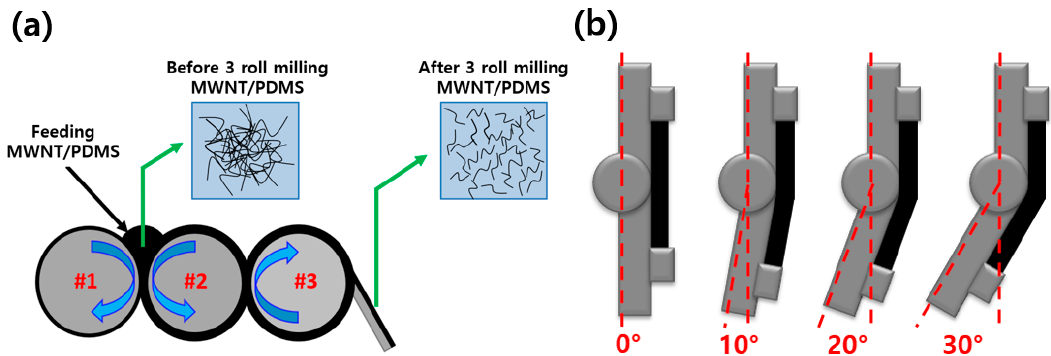
Figure 1. Schematic of ( a ) mechanism for the dispersion of multi-walled nanotubes (MWNTs) in composites by three-roll milling and ( b ) bending process of MWNTs/polydimethylsiloxane (PDMS) composites.